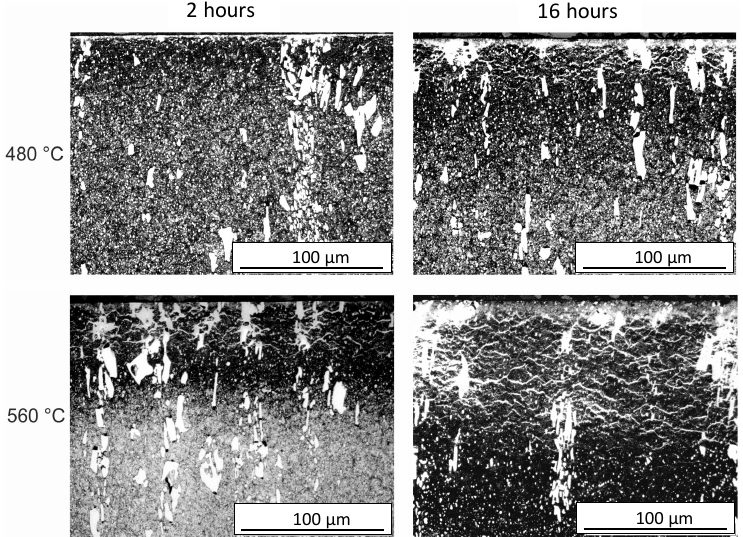
Figure 7. Optical microscopy images of X153CrMoV12 after plasma nitriding at different temperatures and times. The bright layer near the surface indicates the CL, and the darker area marks the DL. The increase in layer thickness is clearly visible with increasing temperature and time.